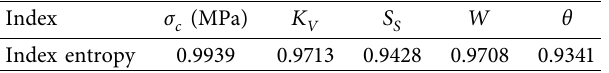
Table 4: The entropy weight matrix.